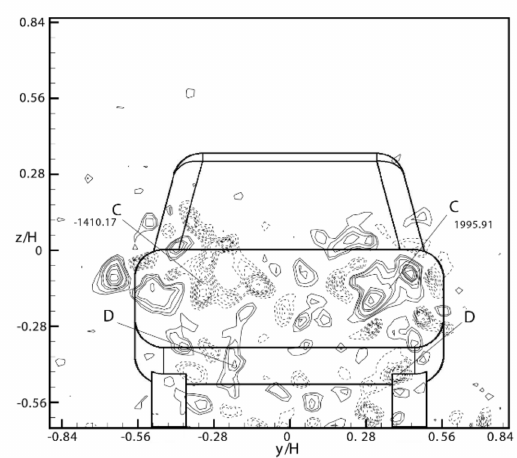
Figure 15. Iso-contours of instantaneous streamwise vorticity ω x in the y–z plane at x/H = 0.67. Minimum and incremental values of vorticity are ω x,min = − 406.435 s − 1 , 284.304 s − 1 , and − 1 , ∆ ω x = 236.474 s